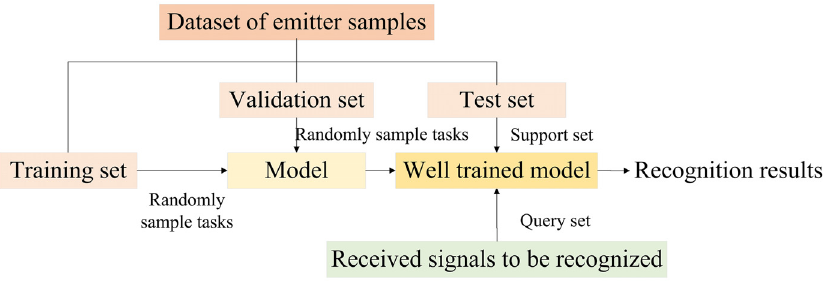
Figure 3. The process of realizing few-shot radar emitter signal recognition.